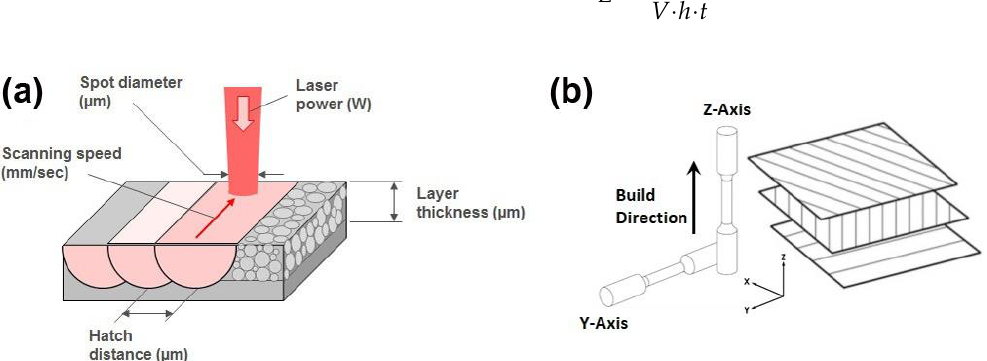
Figure 1. Main parameters and axes in SLM process: ( a ) parameters denoted in one layer and ( b ) axes, build direction, and scan pattern strategy used for layers in SLM samples.